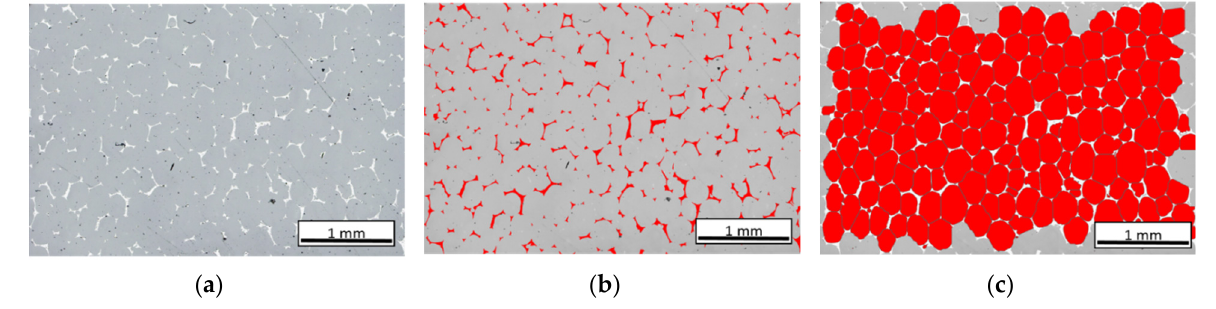
Figure 2. Automatic detection steps procedure of carbon foam cells and carbon skeleton in the LM image, ( a ) initial image, median filter, erosion 1 pp, ( b ) multiple binarization bright image (image ( a )), removal of elements smaller than 100 pixels, ( c ) inversion image a, modified segmentation, manual correction remove frame, erosion with step 3.